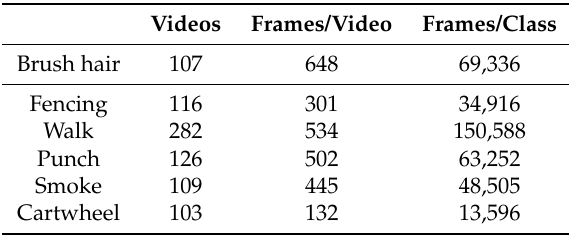
Table 1. Data-set class